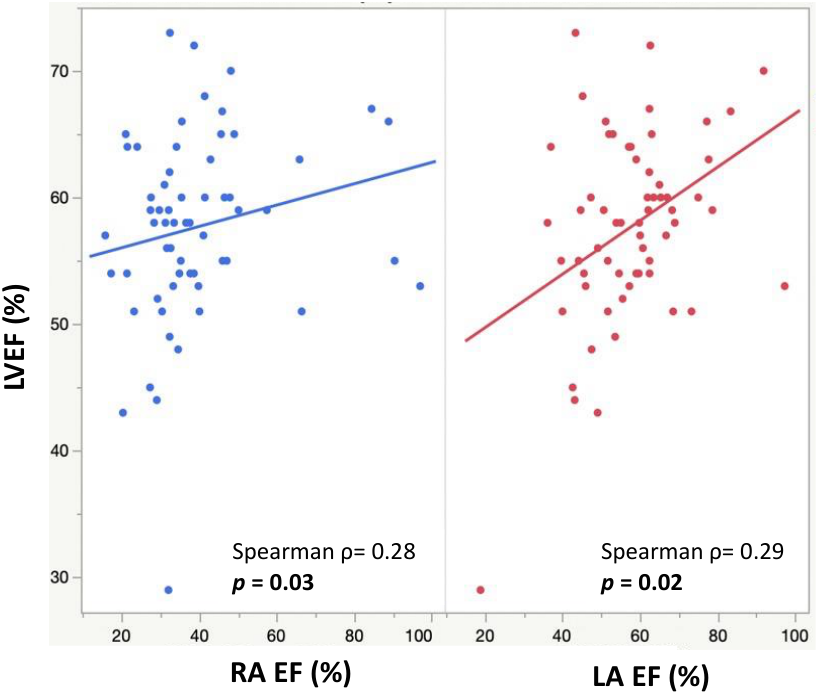
Figure 3. Scatter plots showing indexed minimum and maximum LA and RA volumes and their positive correlations with indexed end-diastolic and end-systolic LV volumes.